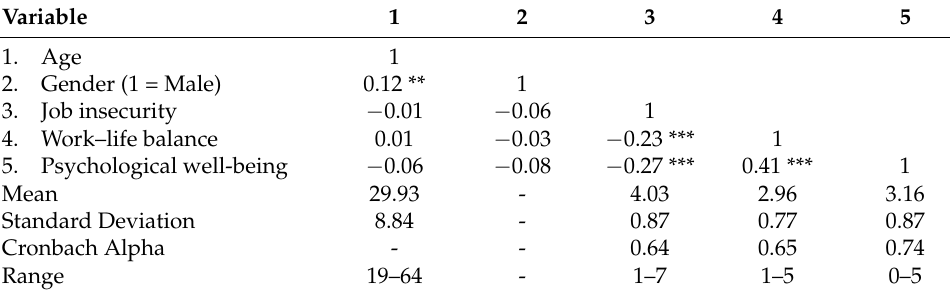
Table 1. Descriptive statistics and correlation for variables.